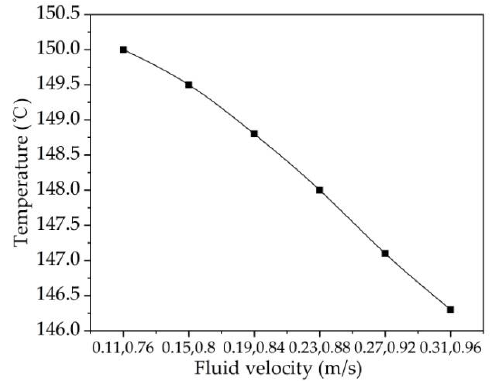
Figure 19. Curve of maximum temperature of IWM with flow velocity.